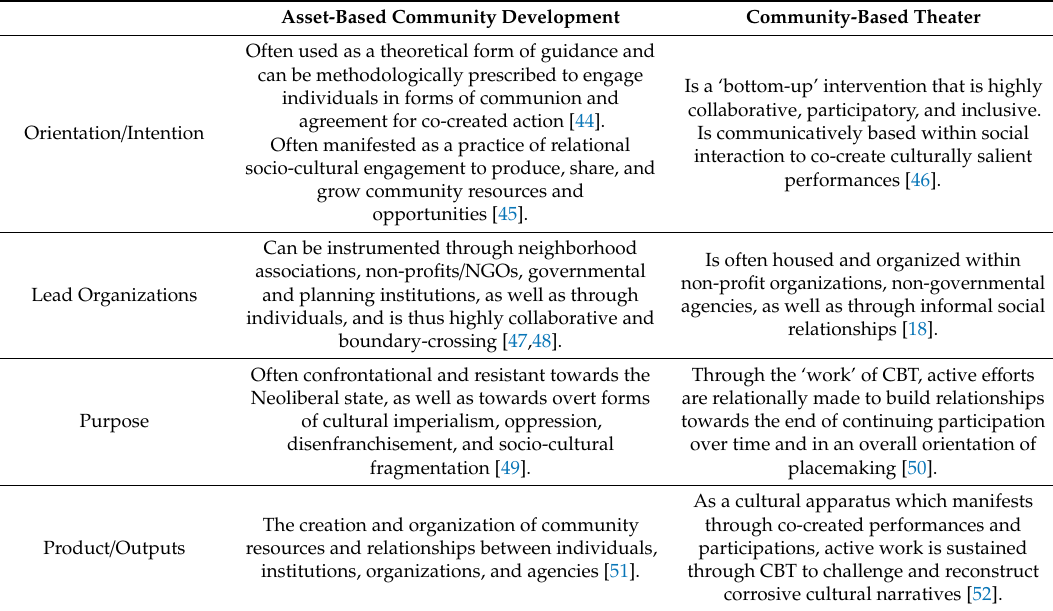
Table 1. A Brief Comparison of Asset-Based Community Development (ABCD) and Community-Based Theater. Asset-Based Community Development Community-Based Theater